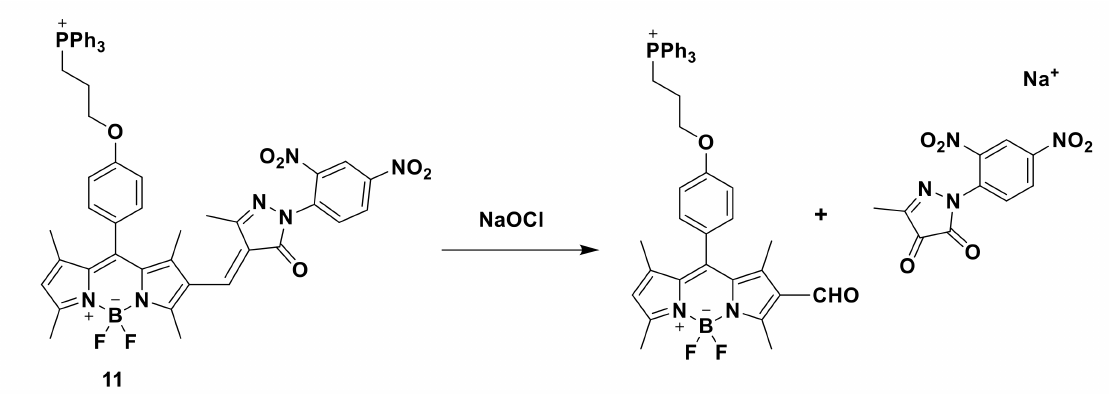
Figure 13. The reaction of probe 11 and ClO −